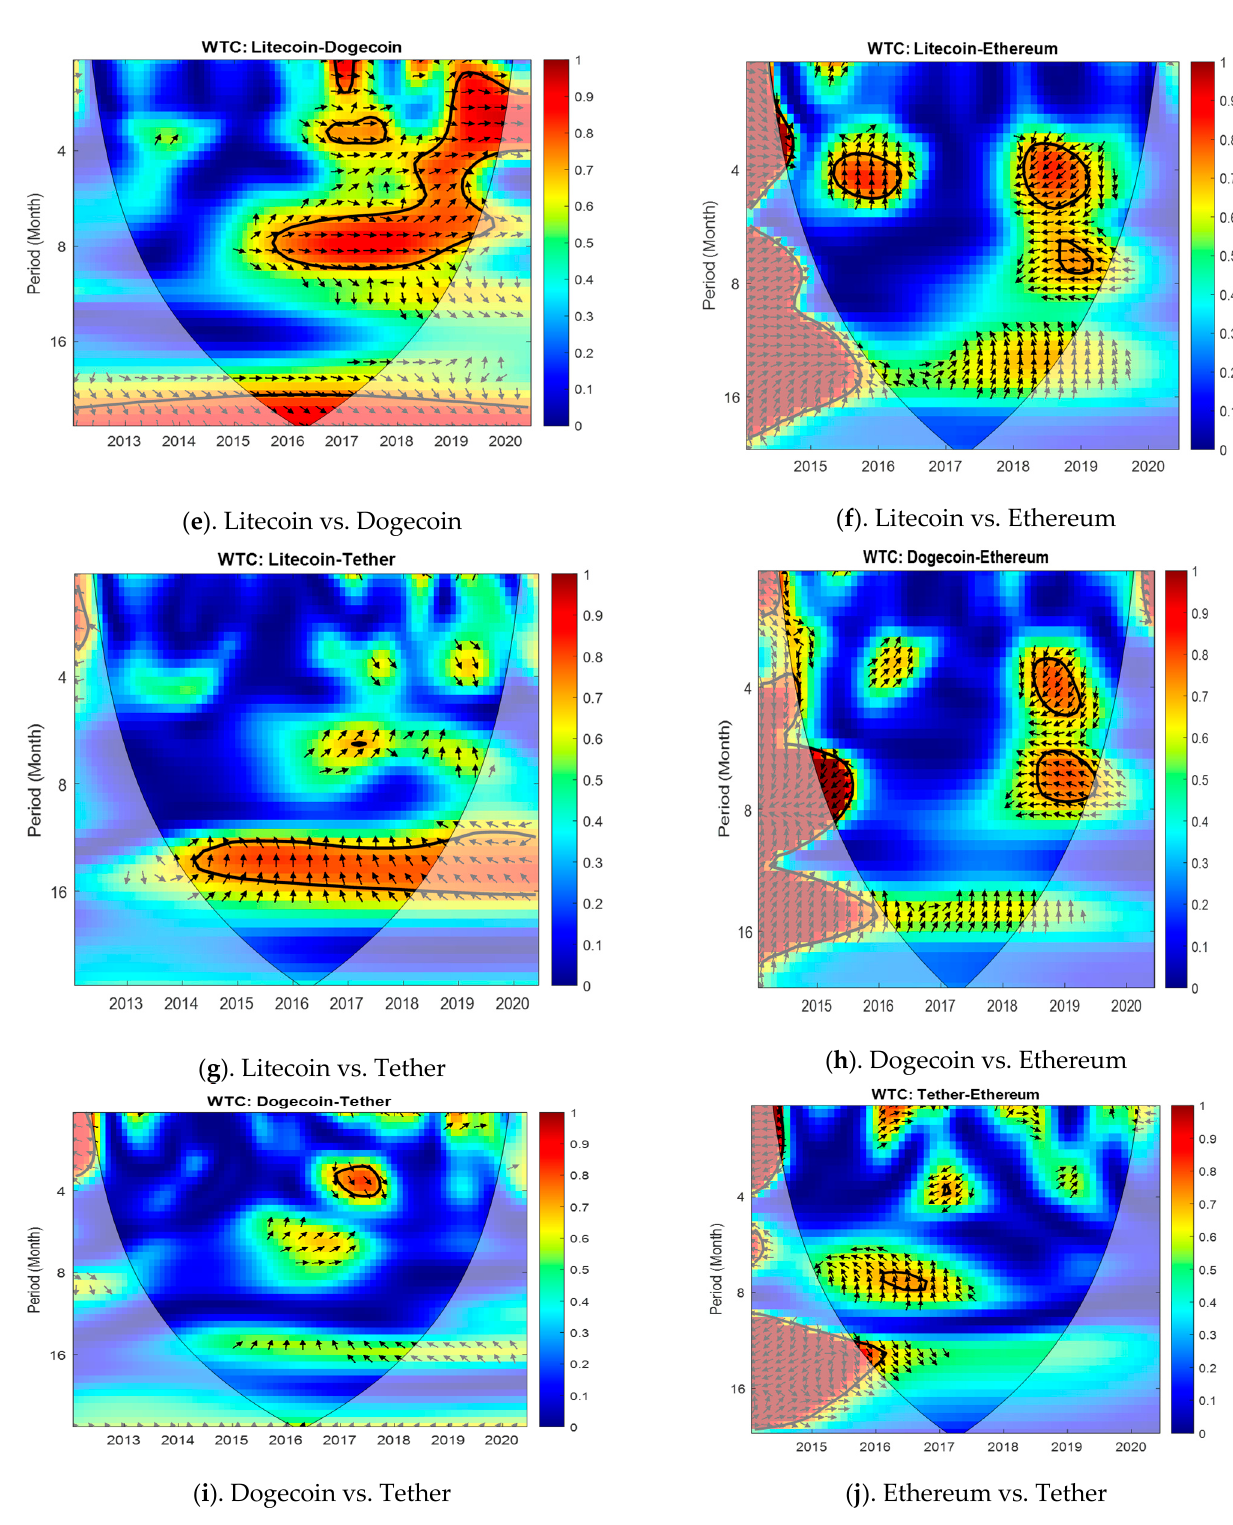
Figure 1. Wavelet coherencies between Bitcoin and altcoins. The black contour recognizes the regions in which the spectrum is significant at the 5% level against red noise. The cone of influence (COI) is designated by the lighter shade, which delimits high power regions, and it delimits the autocorrelation of the wavelet power at each scale. The horizontal and vertical axes denote time and scale bands, respectively.